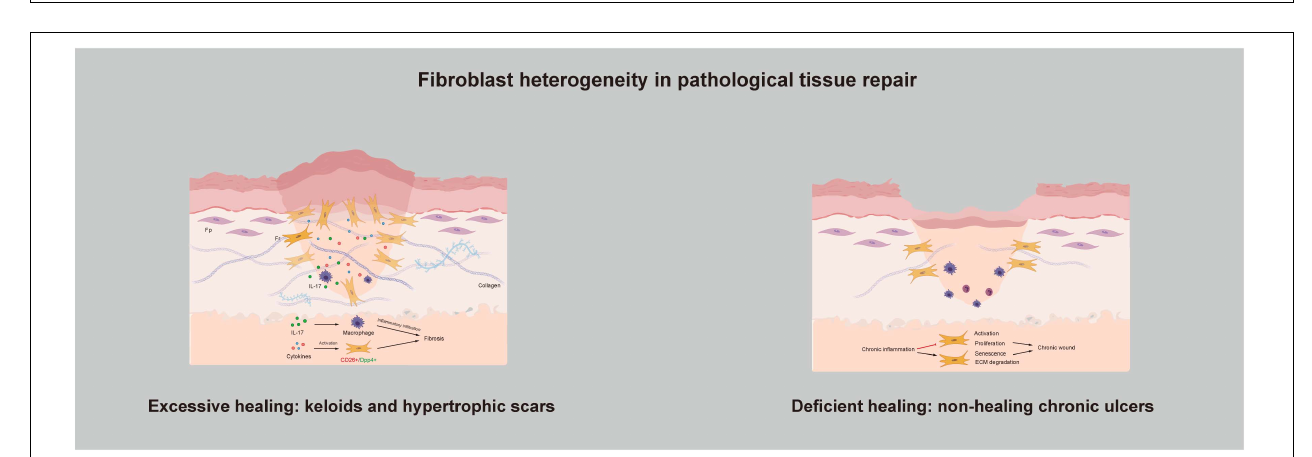
FIGURE 3 | Fibroblast heterogeneity in pathological tissue repair: Excessive healing and deficient